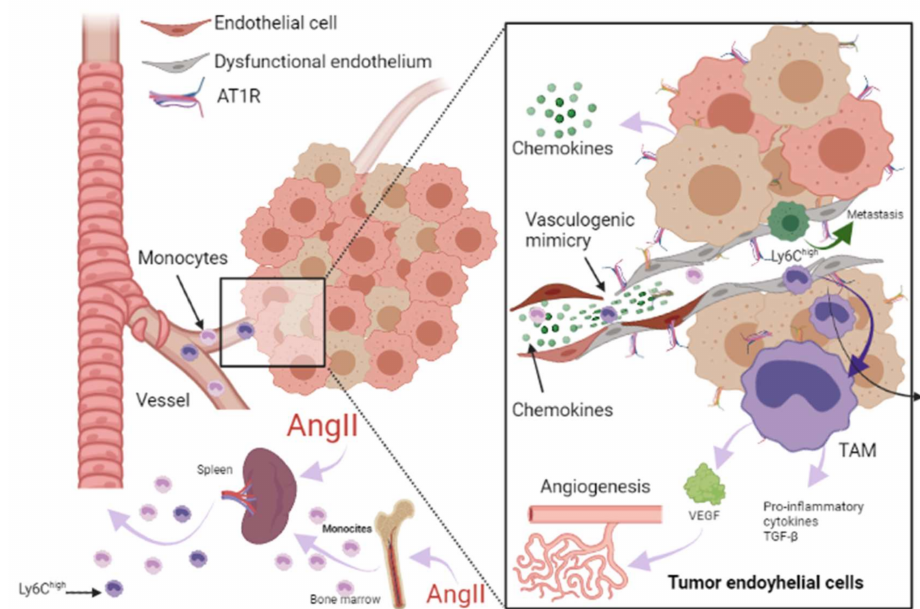
Figure 3. Role of RAAS in the tumor microenvironment. Immune cells can infiltrate tumors and differentiate into tumor-associated macrophages (TAM) derived mainly from circulating monocytes and are attracted to the tumor by chemokines. TAMs can stimulate tumor cell proliferation, an- giogenesis, invasion and metastasis. Additionally, tumor microenvironment (TME) can influence the phenotype of circulating monocytes such as the Ly6C high monocyte subset, giving them an immunosuppressive activity and a decreased responsiveness to inflammatory stimuli before their infiltration intoTME. Angiotensin-II (AngII) plays a relevant role in macrophage-mediated chronic inflammation, increasing macrophage progenitors and supplying of TAMs. Additionally, endothelial cells (EC) can promote pro-inflammatory signaling, favoring spontaneous metastasis in adjacent tumors through an aberrant expression of pro-inflammatory cytokines, extracellular matrix, alter- ations in the leukocyte adhesion process, increasing vascular cell adhesion molecule-1 (VCAM-1) and abnormal responses to oxidative stress. In ECs, AngII/AT1R signaling generates a pro-angiogenic response mediated by vascular endothelial growth factor (VEGF). AngII signaling activates TNF- α and NF- κ B and upregulates pro-inflammatory endothelial chemokines. AngII has been reported to be able to promote VCAM-1 expression and enhance adhesion, growth, angiogenesis, and the inflammatory microenvironment through AT1R in hepatocellular carcinoma. It has been reported that angiogenesis promotes tumor cell metastasis. Image created with BioRender.com, Toronto, ON,